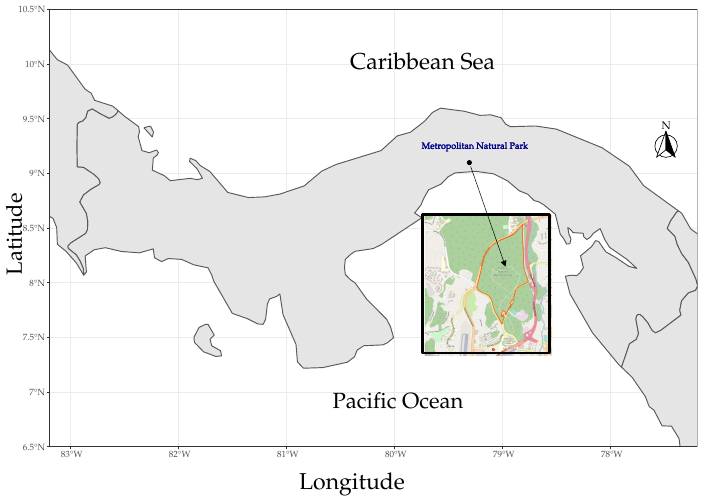
Figure 3. Map with the location of the Metropolitan Natural